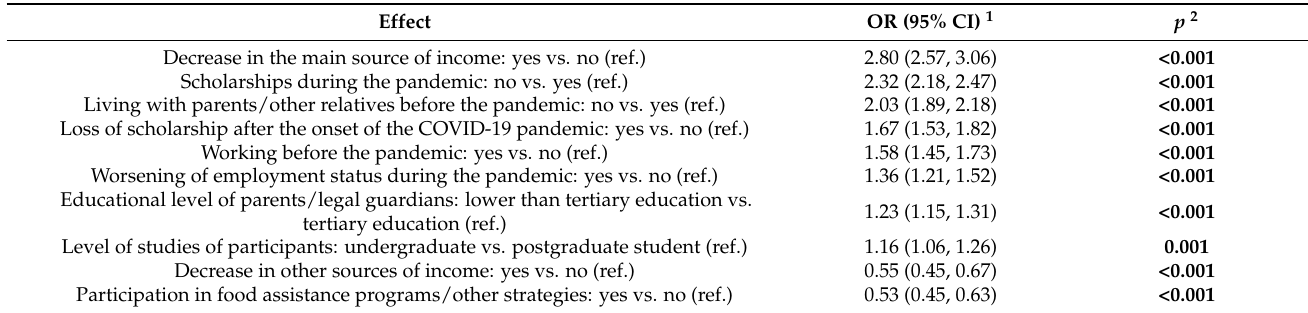
Table 4. Predictors, either as a cause or as a consequence of food insecurity during the COVID-19 pandemic in the sample: students of the University of the Basque Country